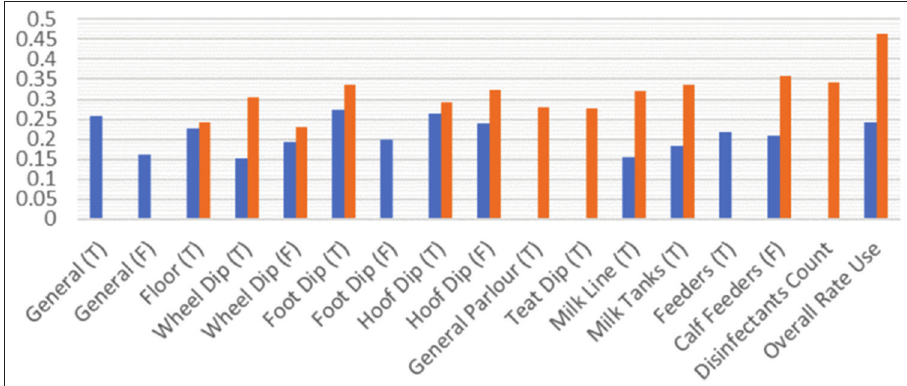
Figure-1: Spearman’s rho correlation coefficient between microbial profile count and presence of resistant strain, with particular disinfectant type (T) and disinfectant frequency of use or change (F). in Table-3 which also shown the serotyping of these chlorine-resistant